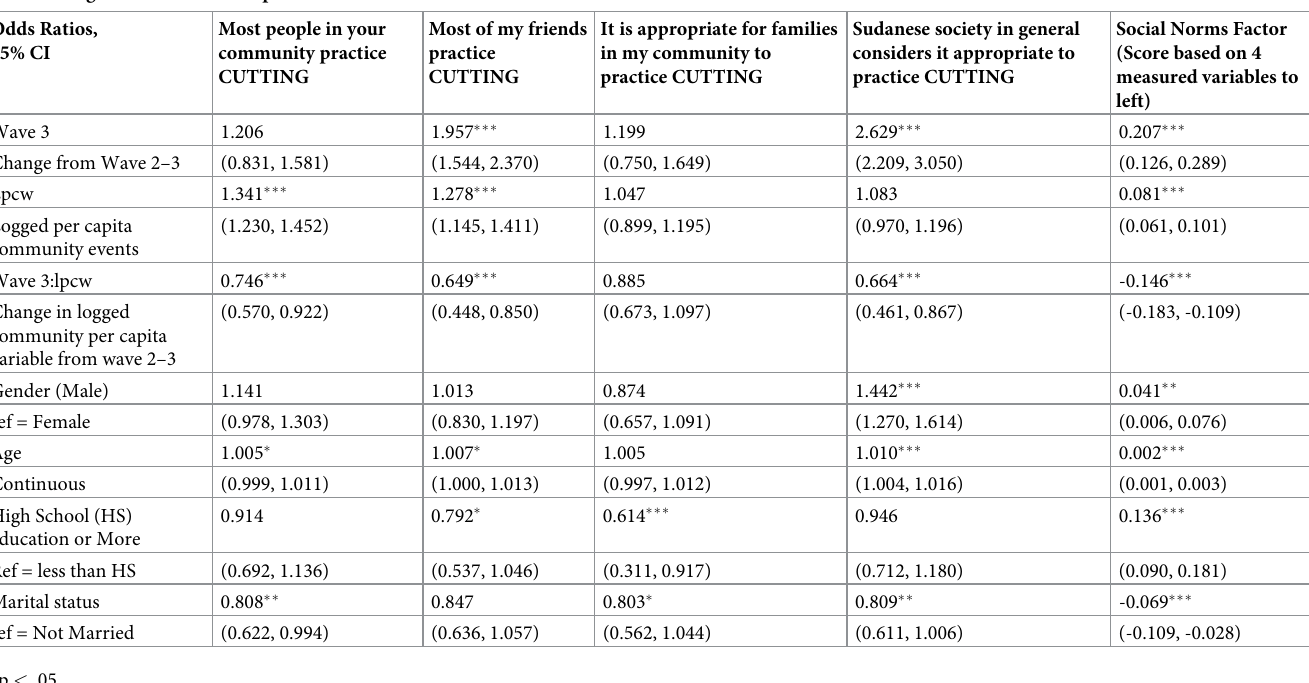
Table 4. Regressions of events exposure on social norms waves 2–3. Odds Ratios, 95%